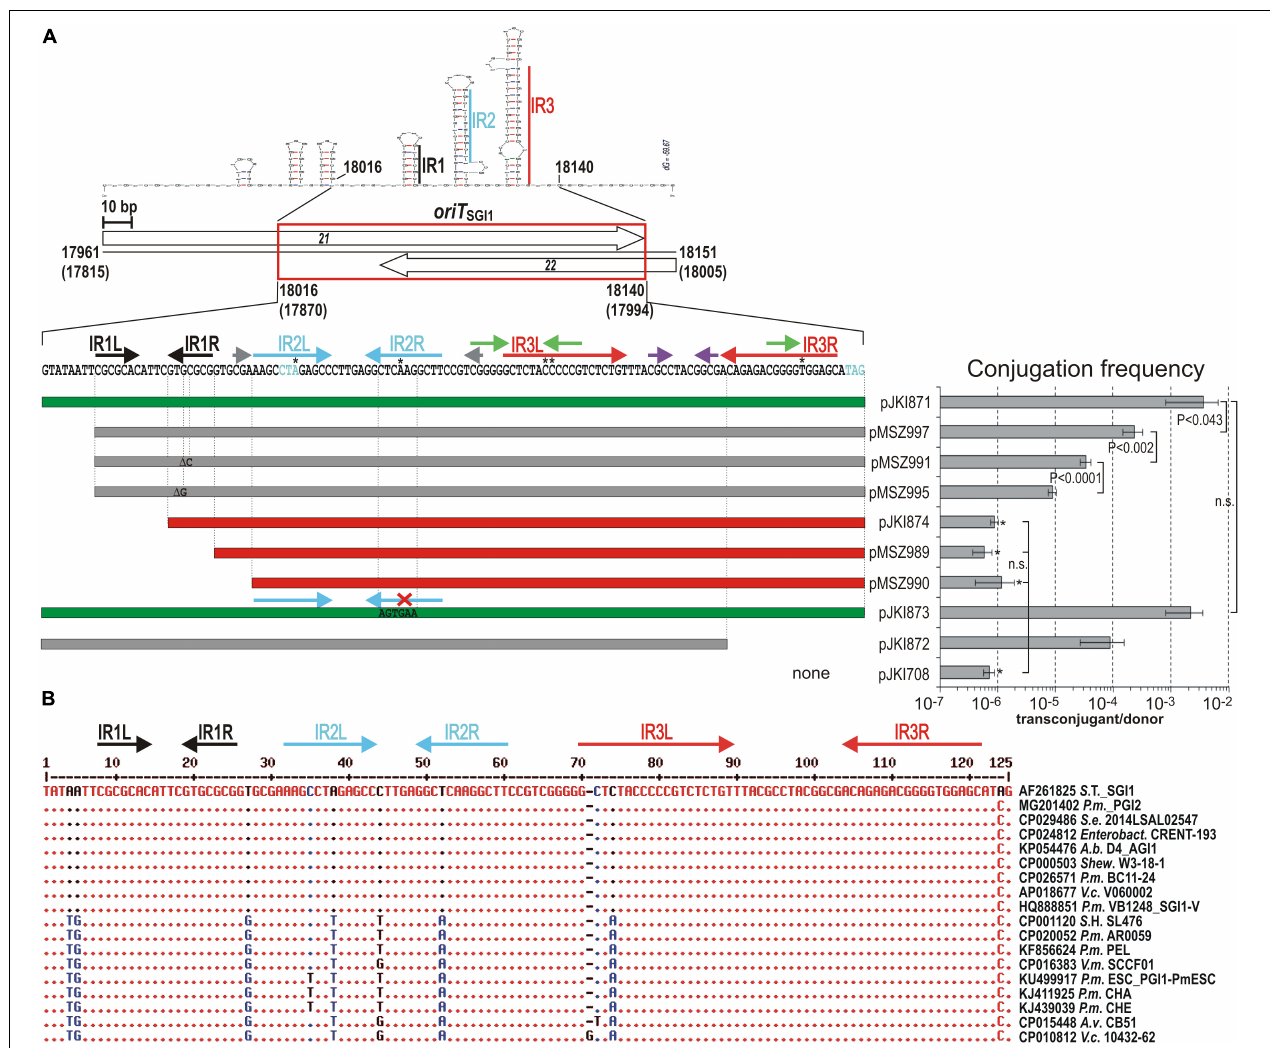
FIGURE 2 | Mutation and comparative analysis of oriT SGI1 . (A) Functional analysis of oriT SGI1 . The location of fully functional oriT is indicated by red box in the schematic map. The SGI1 coordinates are indicated as in Figure 1 . Repeated motifs are shown above the sequence by color-coded arrows. Left and right arms of the inverted repeats longer than 6 bp are designated as IR1/2/3L and R, respectively. Asterisks above the sequence indicate mismatching bases in the IRs. The potential secondary structure of the region and the stem-forming IRs are also shown. Shortened or mutated subclones of oriT are represented by color-coded horizontal bars: green – wt transfer rate; gray – reduced transfer rate; red – not mobilizable. Single base deletions and the sequence of mutagenized IR2R are indicated in the respective bars. The transfer frequencies of the pJKI708-derivative constructs were measured using the mob SGI1 -donor and TG2 recipient strains. Asterisk indicates that the transfer frequency was close to or below the detection limit. The rare Tc R Sm R colonies carried also the helper plasmid (co-transfer was ∼ 100 %) indicating that they did not result from in trans mobilization of the test plasmids. In all statistical evaluations paired t-test was used to calculate the significance of the differences. n.s. – not significant, other symbols are as in Figure 1A . (B) Comparison of the homologous sequences to oriT SGI1 in SGI1-related elements found in the GenBank database. The alignment shows the sequence divergence in the oriT SGI1 regions of 63 fully sequenced relatives of SGI1 (for